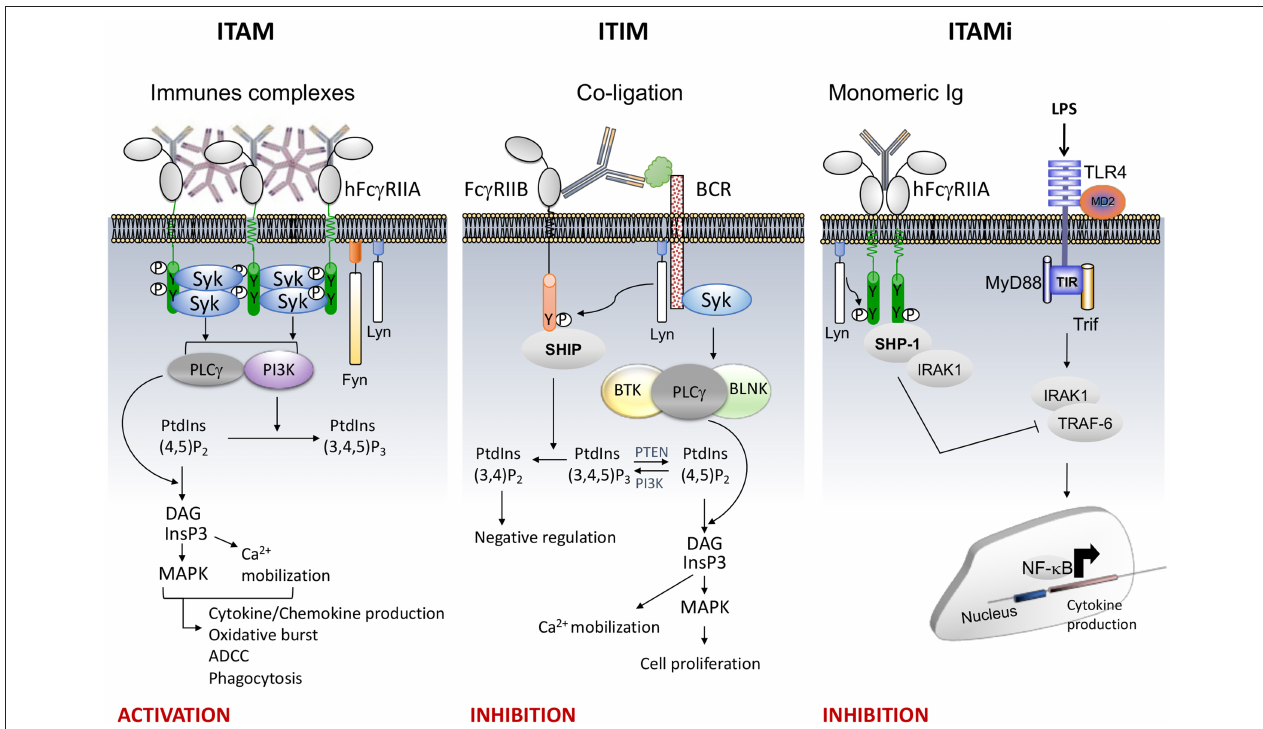
FIGURE 1 | FcR signaling (e.g., Fc γ RII). (Left) , the aggregation by an immune complex of FcR bearing ITAM motif (e.g. Fc γ RIIA) induces phosphorylation of the two ITAM tyrosine residues by Src kinases Lyn and Fyn responsible for recruitment and phosphorylation of Syk inducing cellular activation through PLC γ and PI3K signaling pathways. The PLC γ converts PI(4,5)P 2 into IP 3 and DAG. IP 3 , a soluble inositol phosphate, leads to Ca 2 + mobilization while DAG activate MAPK.PI3K converts PI(4,5)P 2 to PI(3,4,5)P 3 allowing recruitment of signal intermediates through their pleckstrin homology (PH) domain (Middle) , co-ligation between an activating heterologous receptor (e.g., the BCR) and the inhibitory FcR (i.e., Fc γ RIIB) induces phosphorylation of the tyrosine present within the ITIM motif by Lyn (5), leading to the phosphorylation and recruitment of phosphatases (SHIP or SHP). The phosphatases PTEN and SHIP1/2 regulate cellular levels of PI(3,4,5)P 3 by hydrolyzing it to PI(4,5)P 2 and PI(3,4)P 2 , respectively. These dephosphorylations inhibit cell proliferation. (Right) , monovalent targeting of FcR bearing ITAM motif